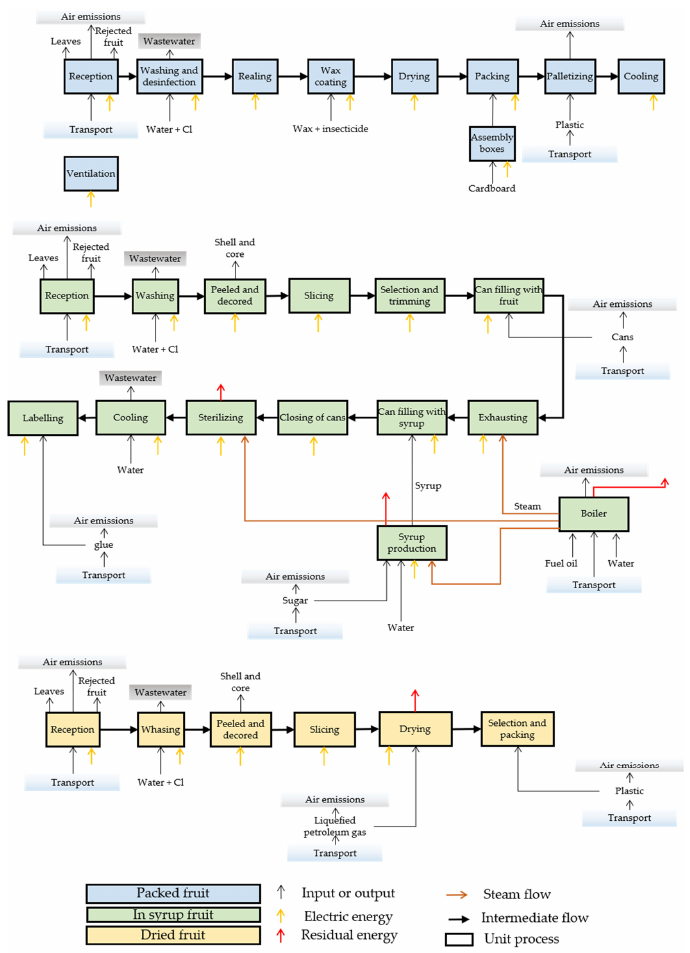
Figure 4. Unit processes that are part of the packing, preserving, and dehydrating industry. Source: own elaboration.